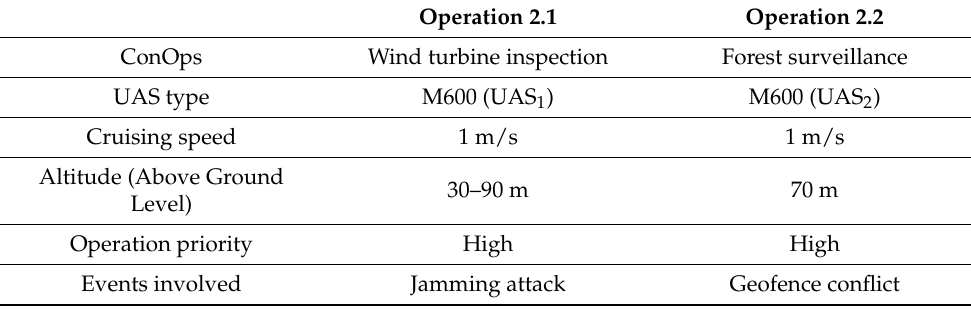
Table 6. Operational parameters for the use case